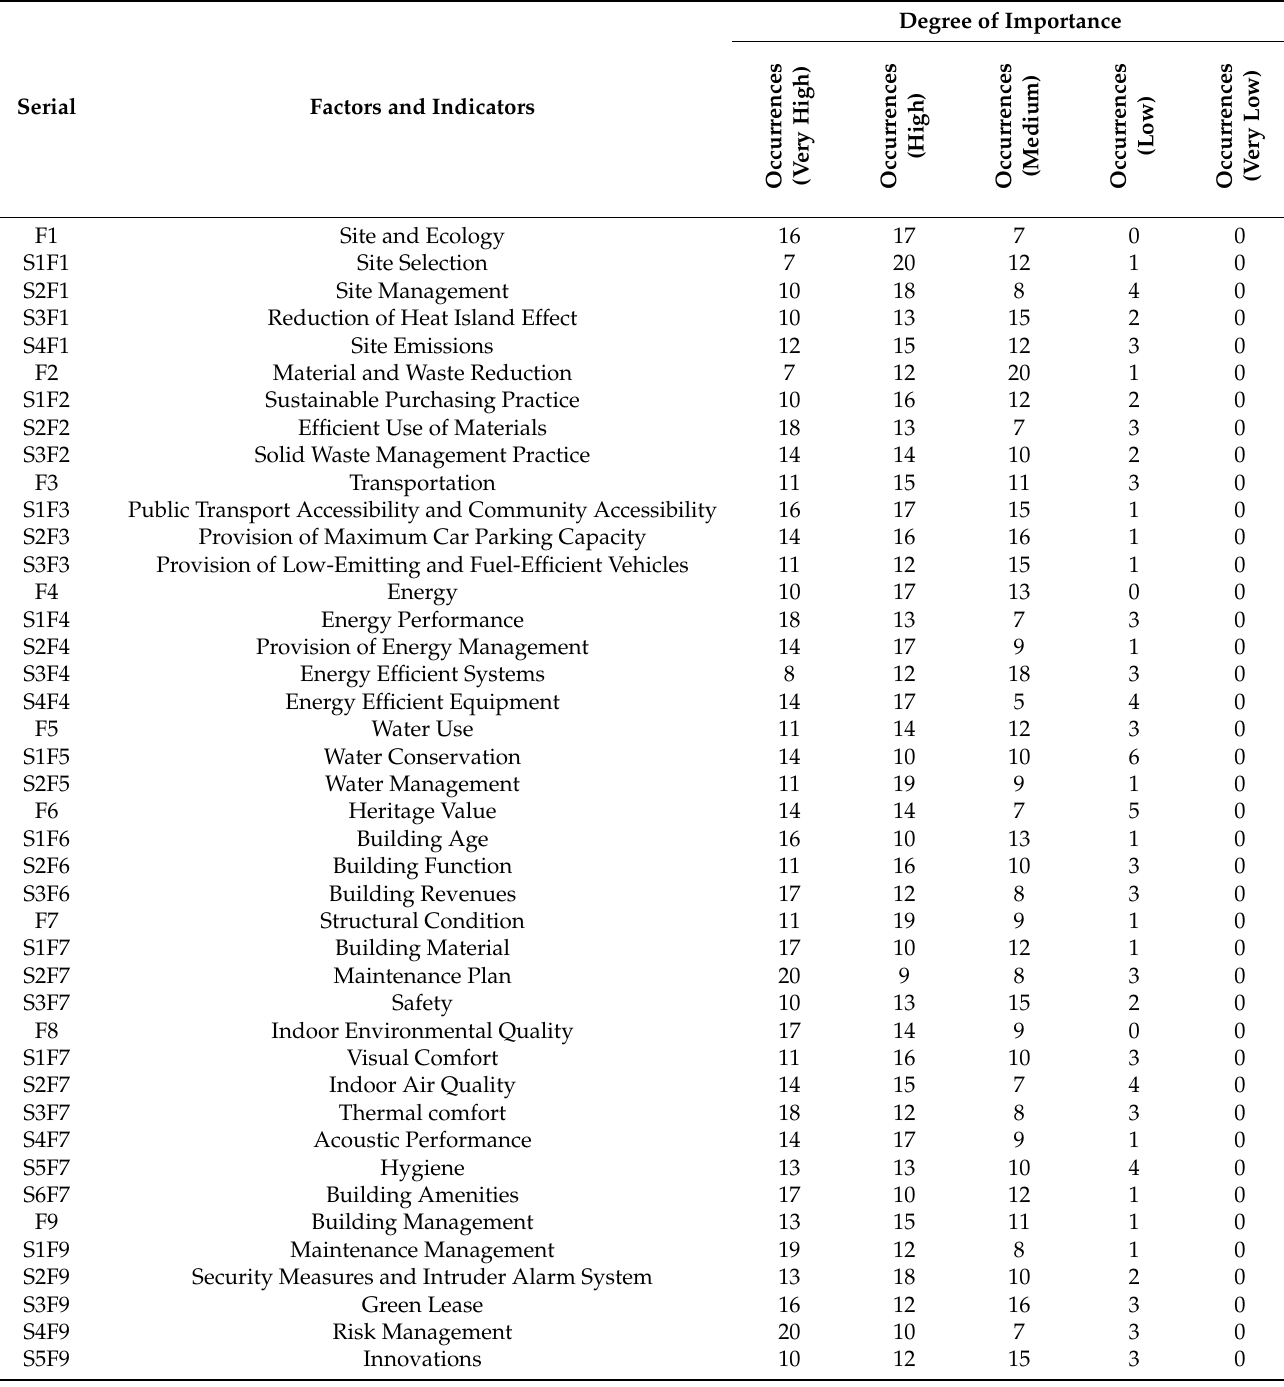
Table 1. Frequency of degree of importance for each factor and